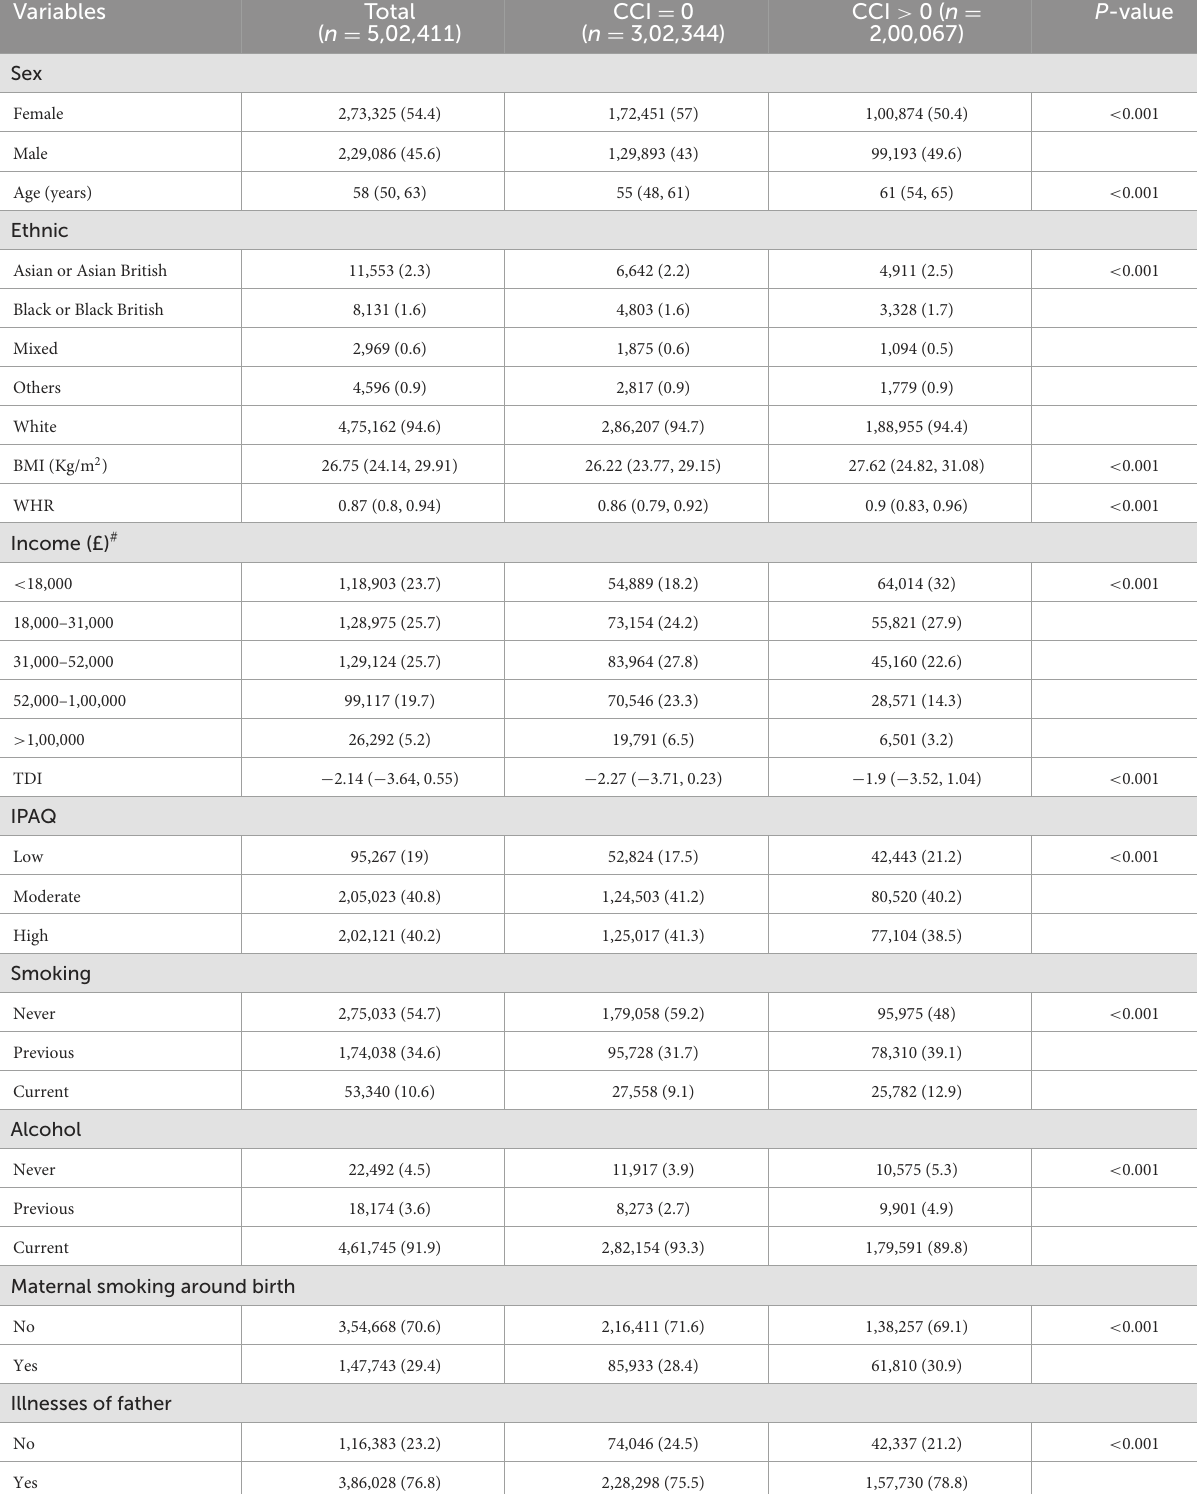
TABLE 1 General characteristics of the CCI group [Median (Q1, Q3)/ n